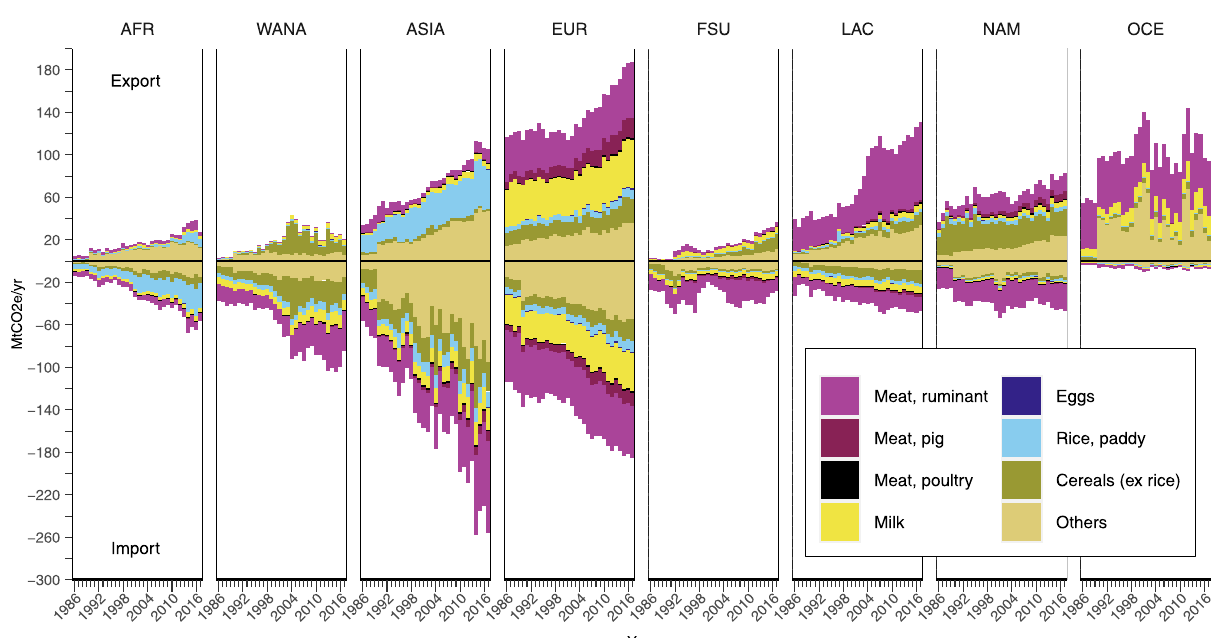
Fig. 3 Regional changes in emissions embodied in food exports and imports from 1986 to 2017. Emissions embodied in exports are shown at the top half of the fi gure, while imports are shown at the bottom half. The regions analysed are Africa (AFR), Western Asia and Northern Africa (WANA), Asia (ASIA), Europe (EUR), Former Soviet Union (FSU), Latin America and the Caribbean (LAC), North America (NAM), and Oceania (OCE). Additionally, the fi gure also provides a breakdown of the contribution of each food group. Values are shown for individual years, i.e., without averaging values for three